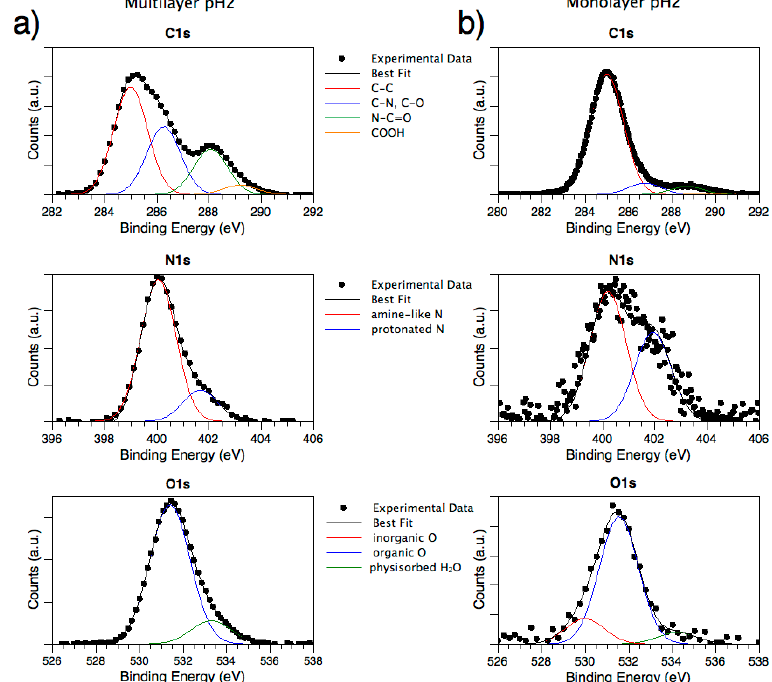
Figure 5. ( a ) X-ray Photoemission Spectroscopy (XPS) C1s, N1s, O1s MUL sample pH 2; ( b ) XPS C1s, N1s, O1s ML sample pH N1s, O1s ML sample pH 2.